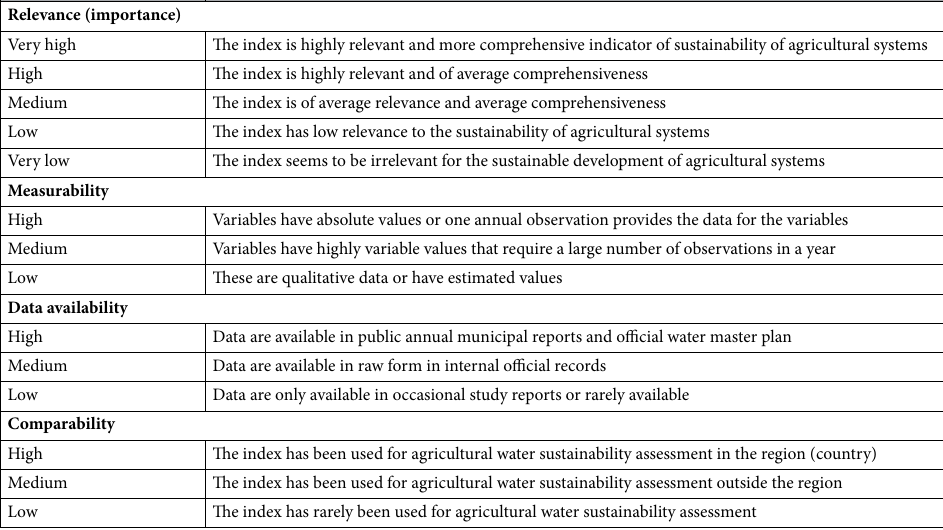
Table 2. Selected criteria for assessing the SPIs. (References 39–42